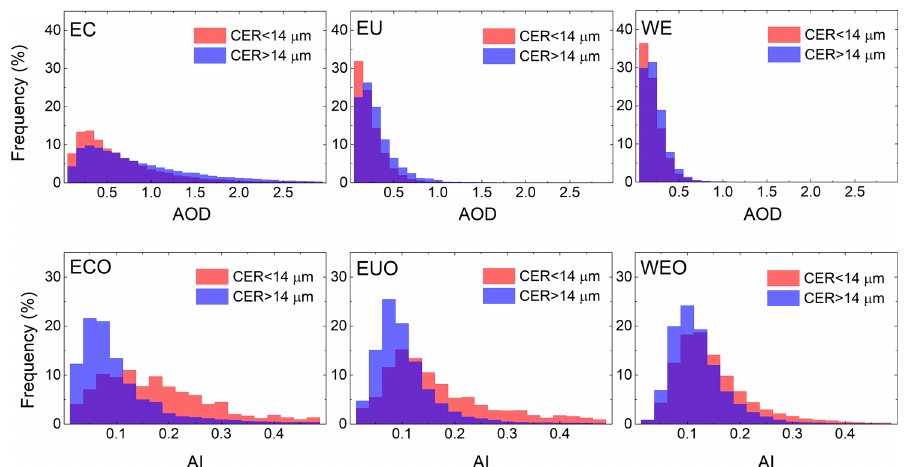
Figure 8. Probability density functions of AOD (AI) for CER > 14µm (blue) and CER < 14µm (red) over three anthropogenic regions (EC, EU, and WE) and their adjacent oceans (ECO, EUO, and WEO).